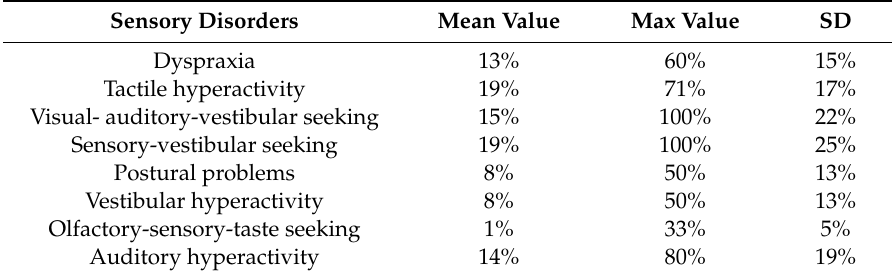
Table 3. Results of the sensory profile.